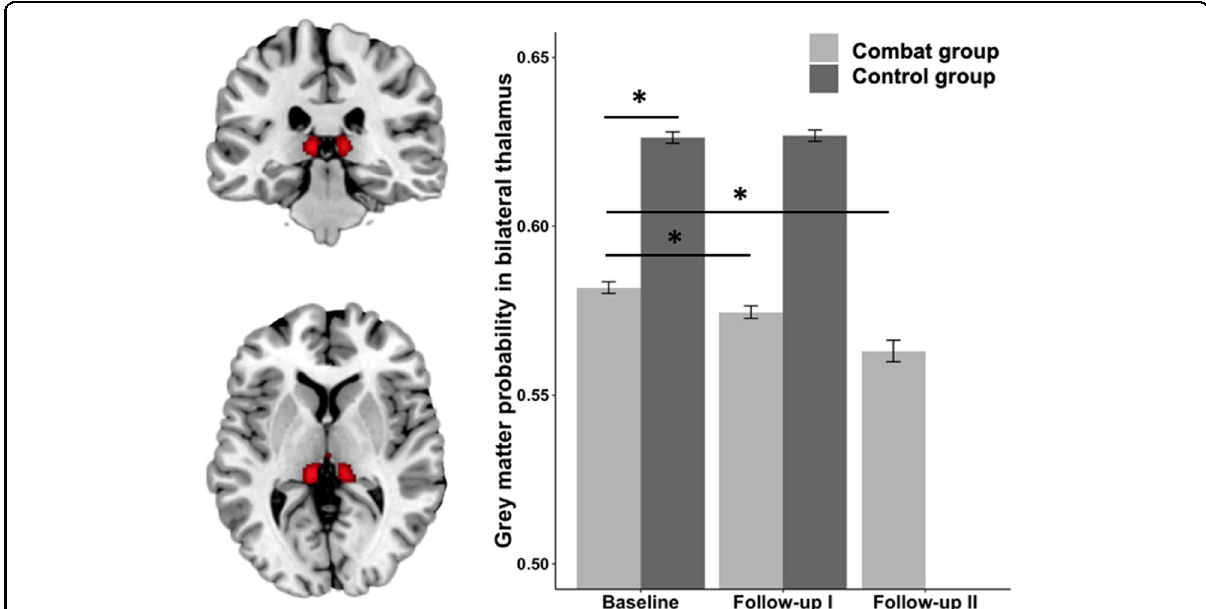
Fig. 2 On the left results of the voxel-based morphometry whole-brain group x time interaction showing stability in control group and decrease in the combat group (FWE-corrected), on the right illustration of the mean gray matter volume extracted from the thalamus cluster. Additionally, mean values for Follow-up II about 6 months after the deployment are shown. Each asterisk indicates signi fi cant results of a paired t -tests ( p < 0.05). Within-subject error bars are computed based on Morey 39